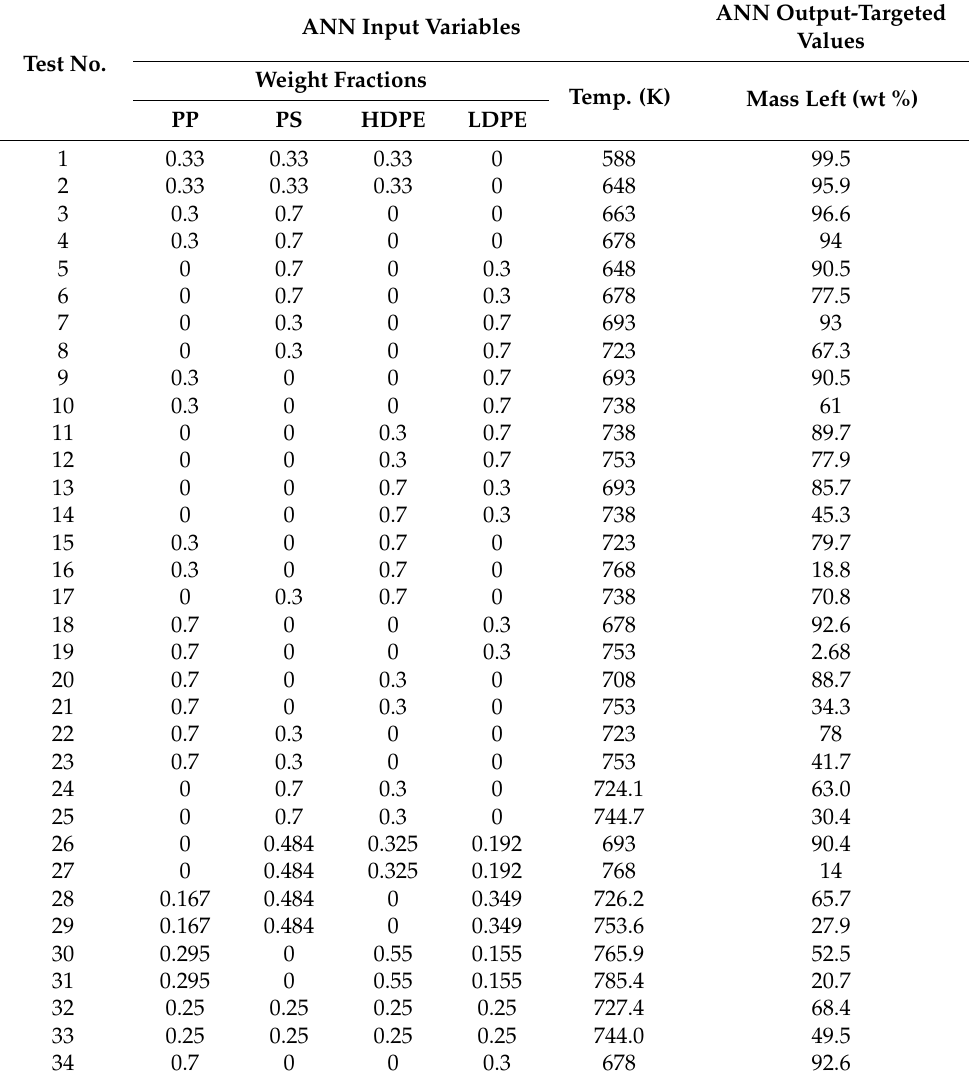
Table 6. ANN-targeted weight left values using the new input datasets for the simulation step.